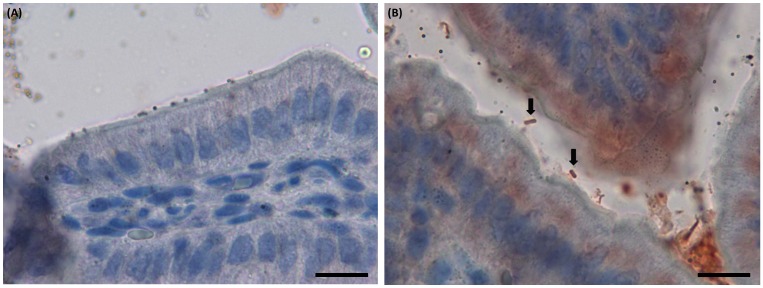
Immunohistochemical analysis of sample sections of ileum of the C. perfringens challenged mice.Mice were intragastrically inoculated with the indicated strains and then sacrificed 48 h post-infection. (A) Sample sections of ileum of the mice challenged with type A strain (Cp88), no attached C. perfringens were observed. Scale bar, 20 μm. (B) In type E challenged mice, many red bacilli corresponding with C. perfringens (black arrows) were observed intimately attached to the intestinal mucosa. Scale bar, 20 μm.